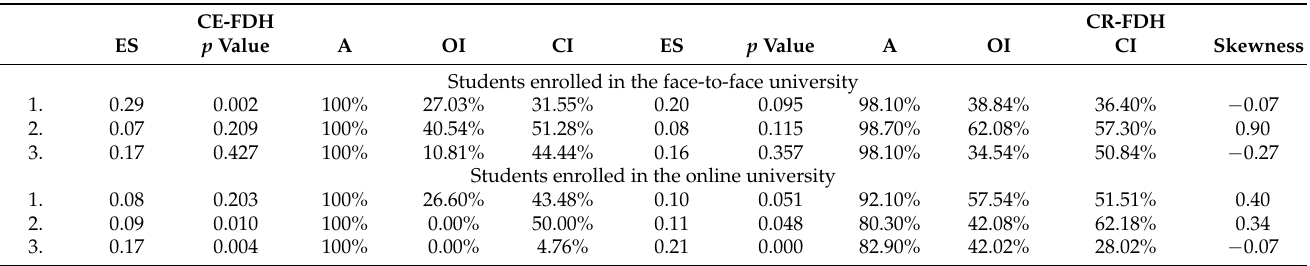
Table 2. Necessary condition effect sizes and significance tests for admission grade, study time, and conscientiousness as predictors of college grade point average (GPA).